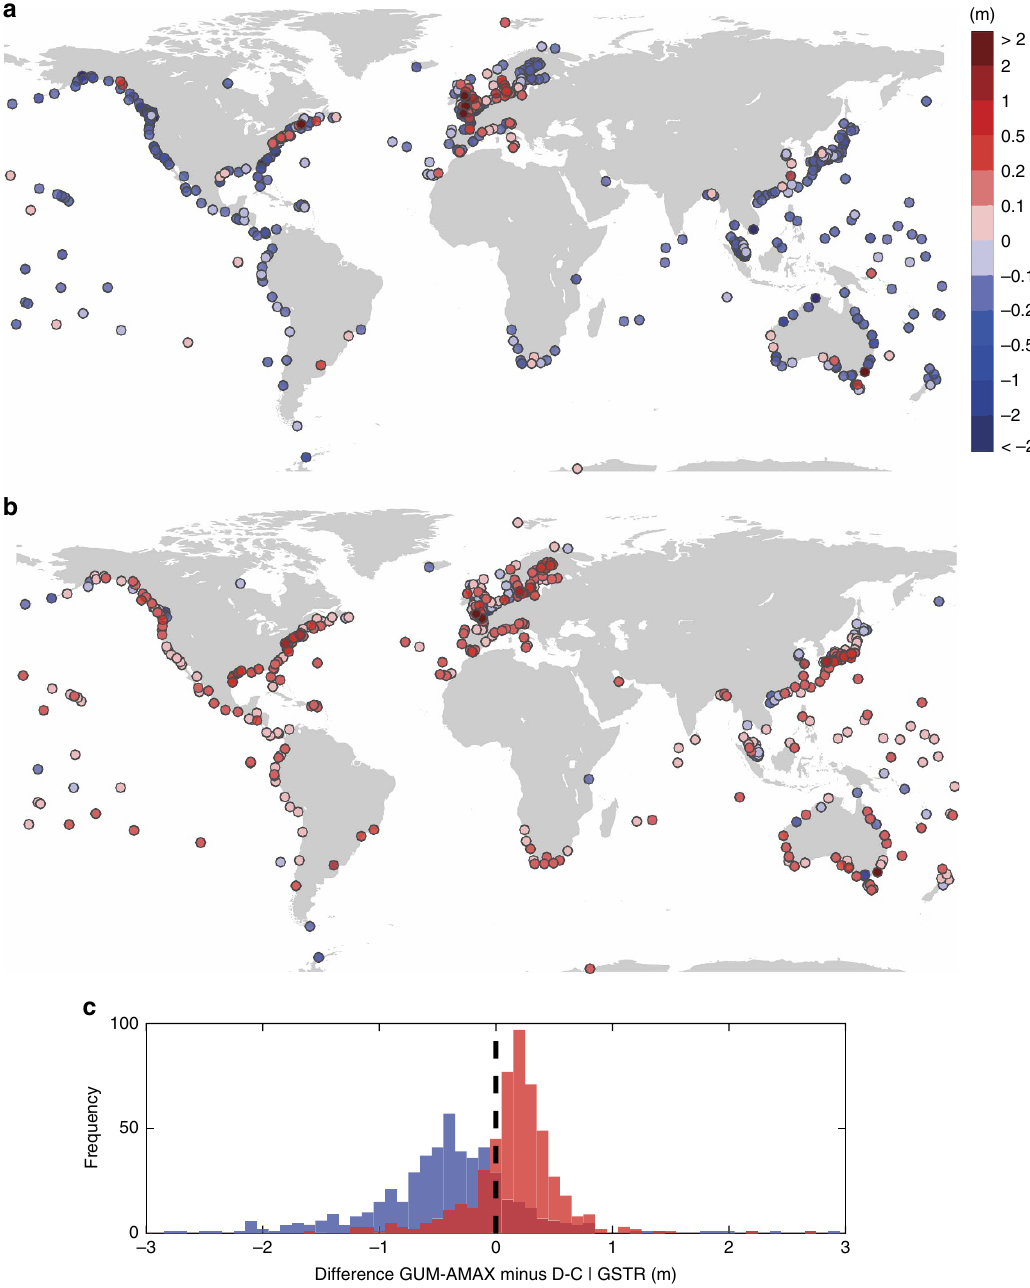
Figure 5 | Offsets between return water levels derived from observations and models. ( a , b ) Differences in 100-year return water levels obtained from tide gauge observations with the Gumbel distribution and annual maxima (GUM-AMAX) method and those from the ( a ) DINAS-COAST (D-C) and ( b ) Global Tide and Surge Reanalysis (GTSR) data sets (negative values indicate that models overestimate extreme sea levels). ( c ) Histograms of differences between 100-year return water levels from observations and D-C (blue) and GTSR